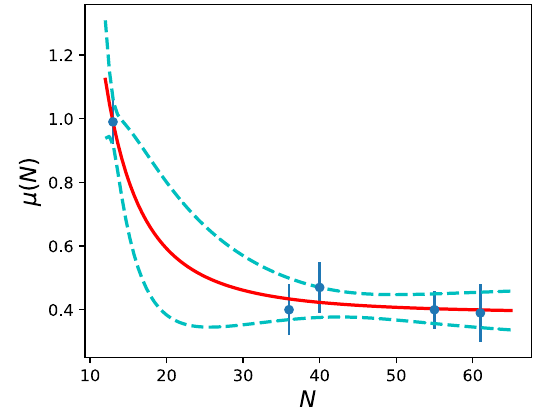
we use in the main text.